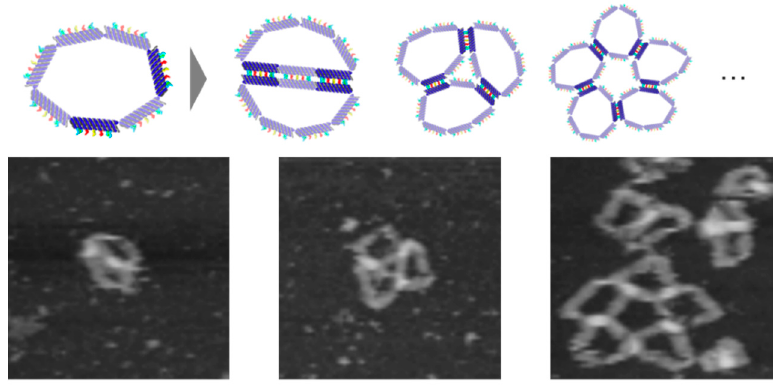
Figure 4. The self-assembly of the motif with two non-adjacent connectable segments. The circular multimer proved the flexibility of the motif. Scale bar = 100 nm.